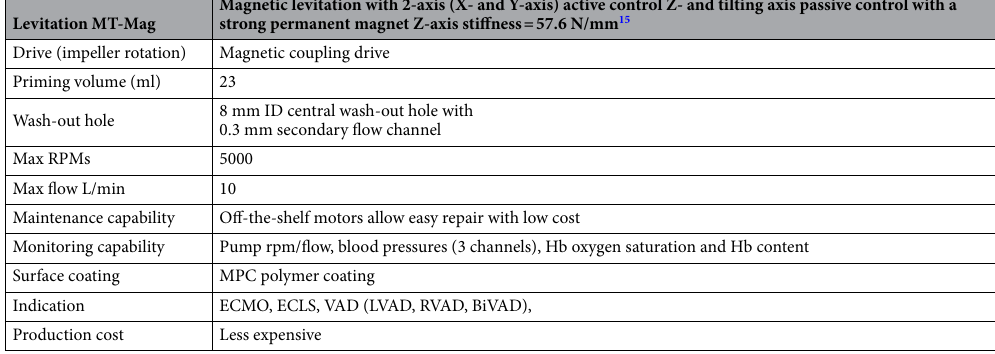
Table 1. Technical specifications of the MT-Mag pump. VAD ventricular assist device, LVAD left ventricular assist device, RVAD right ventricular assist device, BiVAD bi-ventricular assist device, ECMO extracorporeal membrane oxygenation, ECLS extracororeal life support, MPC 2-methacryloyloxyethyl